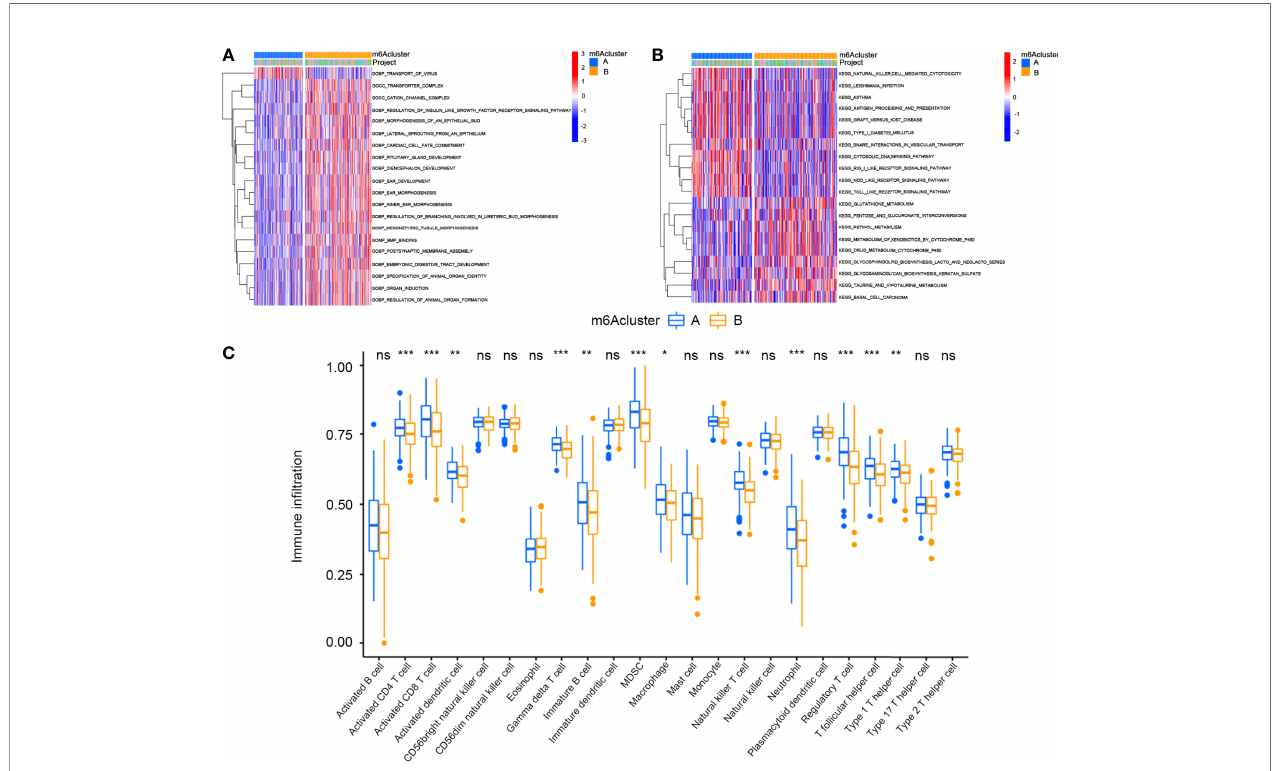
FIGURE 3 | GSVA enrichment analysis and Tumor microenvironments cell in fi ltration characteristics in two m6A Modi fi cation Modes in cervical cancer. (A) GO enrichment analysis. (B) KEGG enrichment analysis. (C) Expression of immune-in fi ltrating cells in two m6A modi fi cation patterns (*P < 0.05, **P < 0.01, and ***P < 0.001). ns, not signi fi